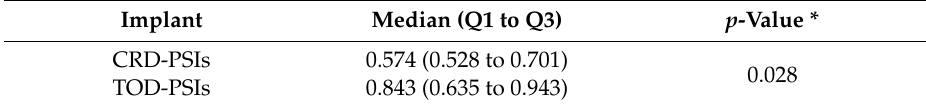
Table 4. Quantitative accuracy assessment for the median RMS values (mm) in the CRD-PSIs and TOD-PSIs.